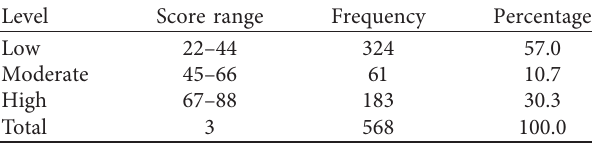
Table 1: Levels of self-regulated learning. Table 2: Levels of academic